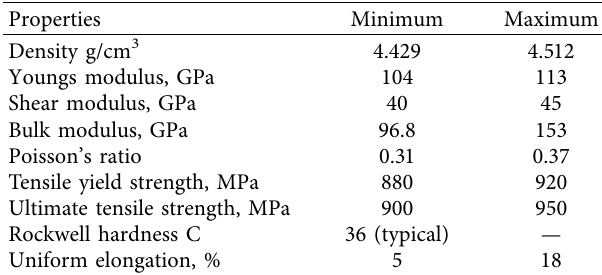
Table 2: Mechanical properties of